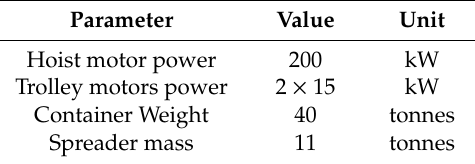
Table 1. Key parameters of the electrified RTG crane model